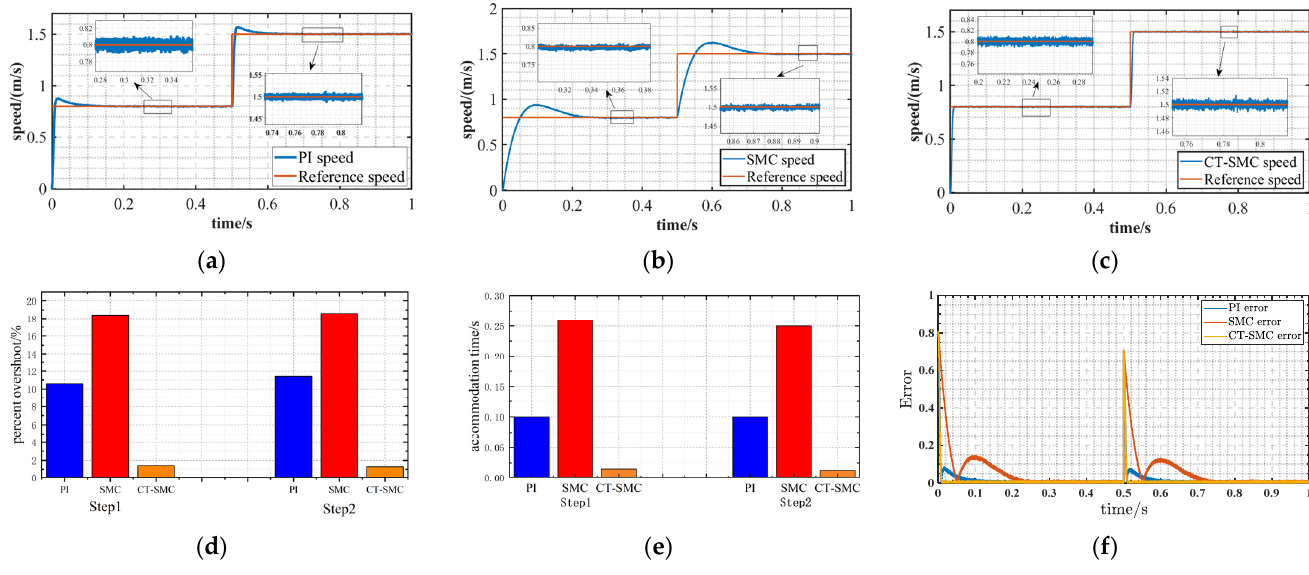
Figure 10. Dynamic performance comparison of the three control effects: ( a ) speed of PI control sys- tem; ( b ) speed of SMC control system; ( c ) speed of CT-SMC control system; ( d ) overshoot comparison of the three control systems; ( e ) adjustment time comparison of the three control systems; ( f ) error comparison of the three control